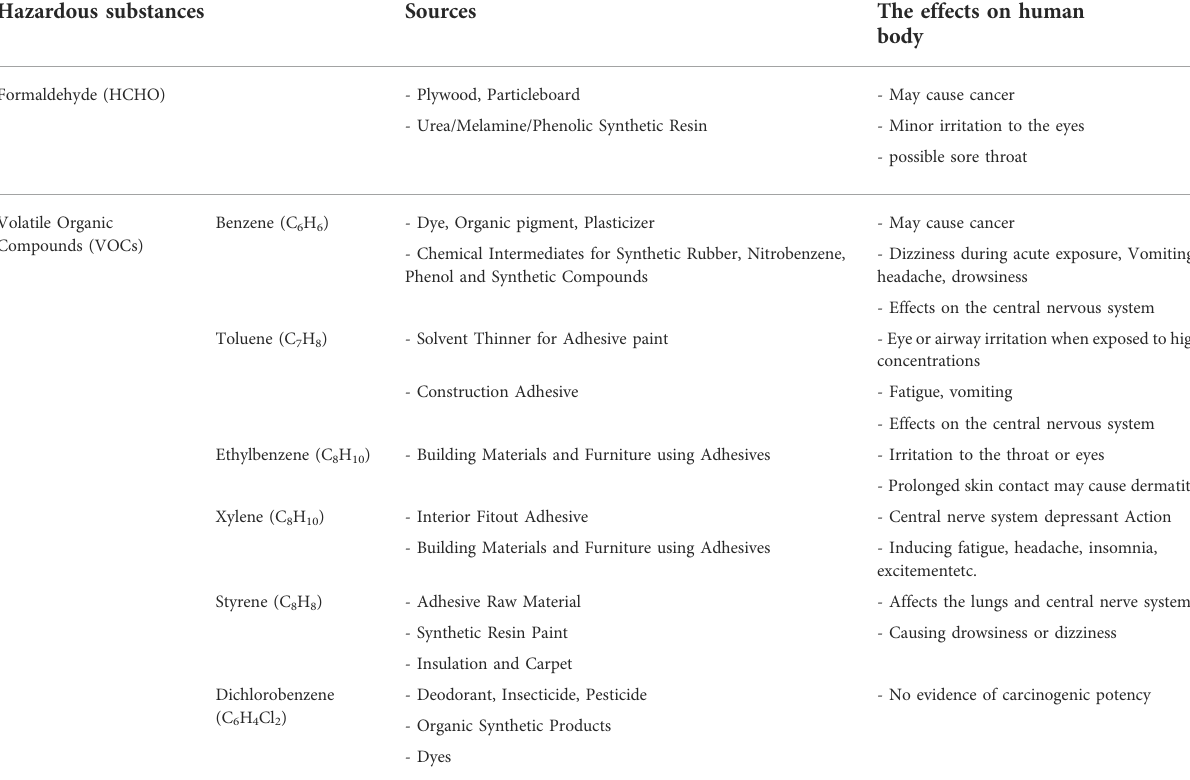
TABLE 1 The effects of hazardous substances on the human body. Hazardous substances Sources The effects on human